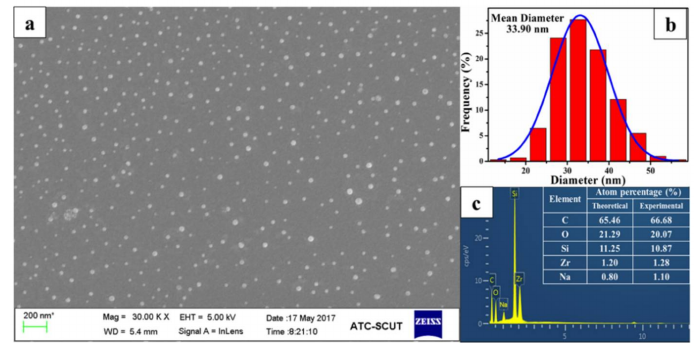
Figure 4. SEM ( a ); diameter distribution ( b ); and SEM-EDS ( c ) of